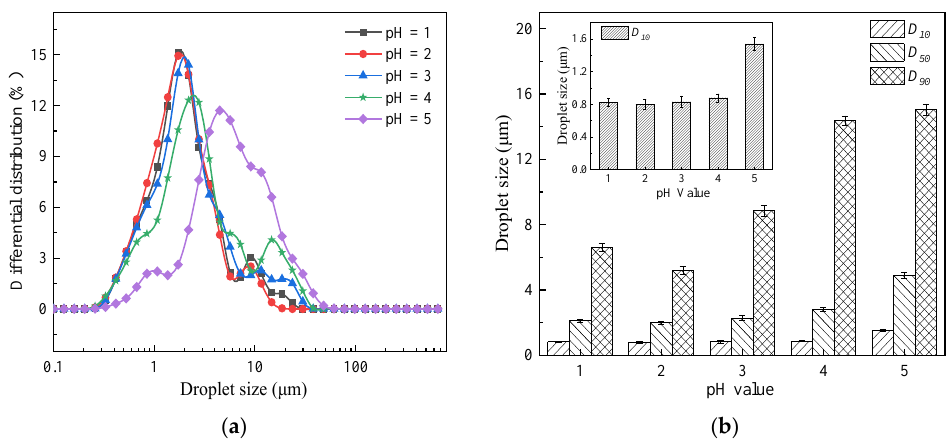
Figure 3. Droplet size distribution of asphalt emulsions fabricated at different pH values. ( a ) Droplet size distribution. ( b ) Representative droplet sizes.